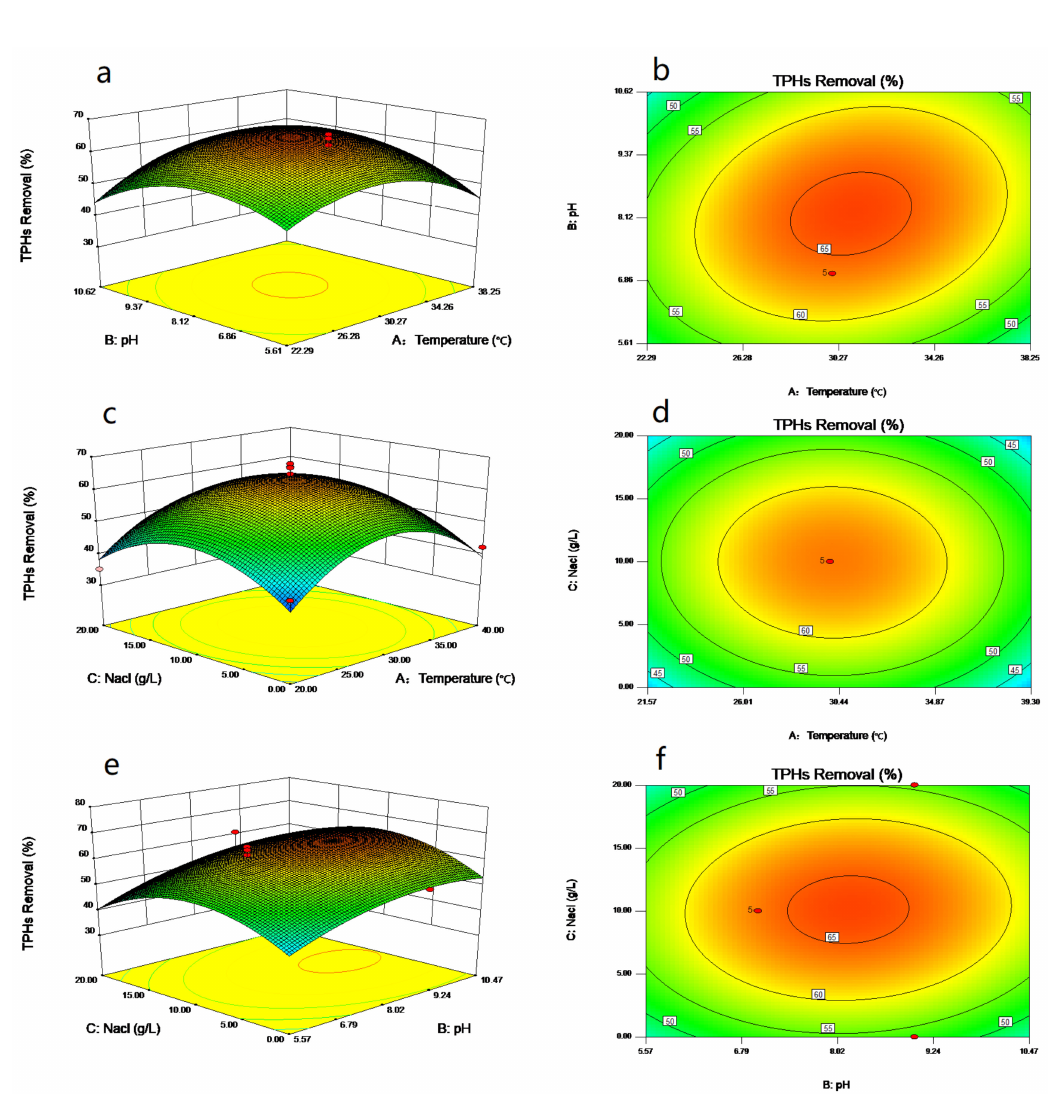
Figure 5. RSM response surface and contour plots for TPH removal as a function of the variables: ( a , b ) Temperature (A) and pH (B), ( c , d ) Temperature (A) and NaCl (C), ( e , f ) pH (B) and NaCl